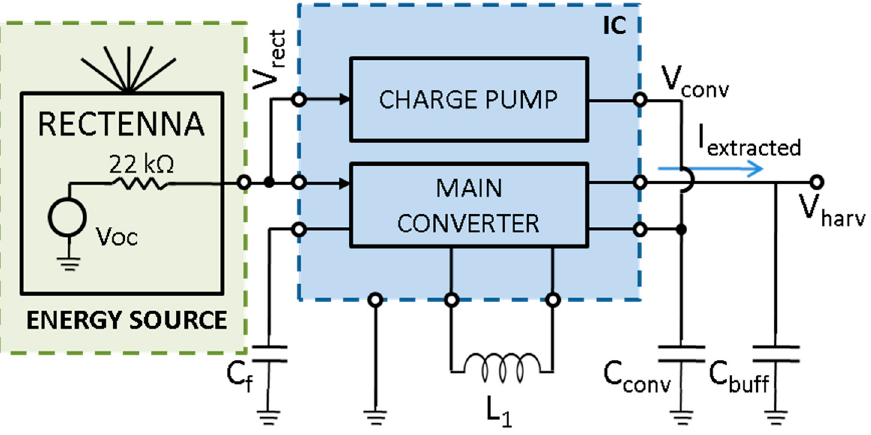
Figure 6. DC/DC low-power converter block diagram.